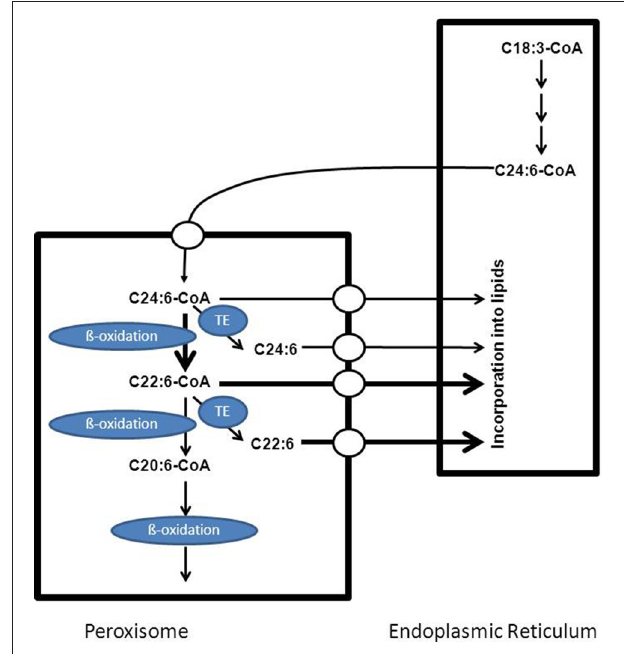
FIGURE 6 | Functional interplay between peroxisomes and mitochondria in the oxidation of C26:0. See text for detailed information. ALDP, adrenoleukodystrophy protein; TE, acyl-CoA thioesterase; CrOT, carnitine octanoyltransferase; CrAT, carnitine acetyltransferase; CACT, mitochondrial carnitine: acylcarnitine translocase.